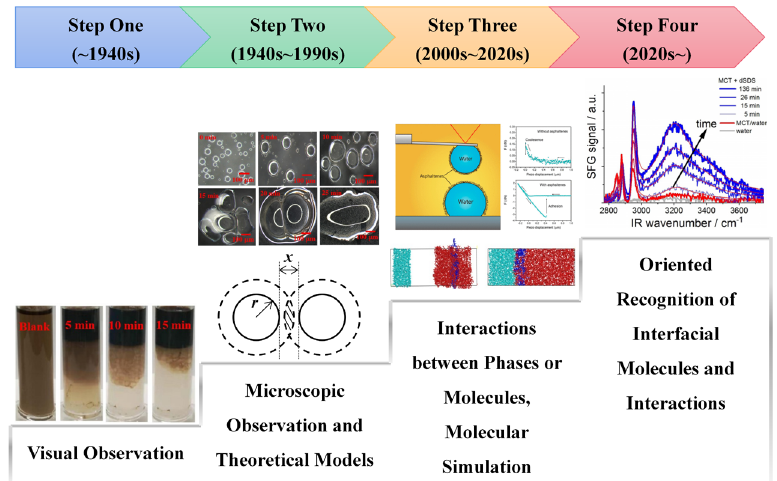
Figure 6. The stages in the investigation of the stability of emulsions. Reproduced with permission from (ref. [99,124–126]). Copyrights of 2019 Elsevier B.V., 2021 Elsevier Ltd., 2017 American Chem-